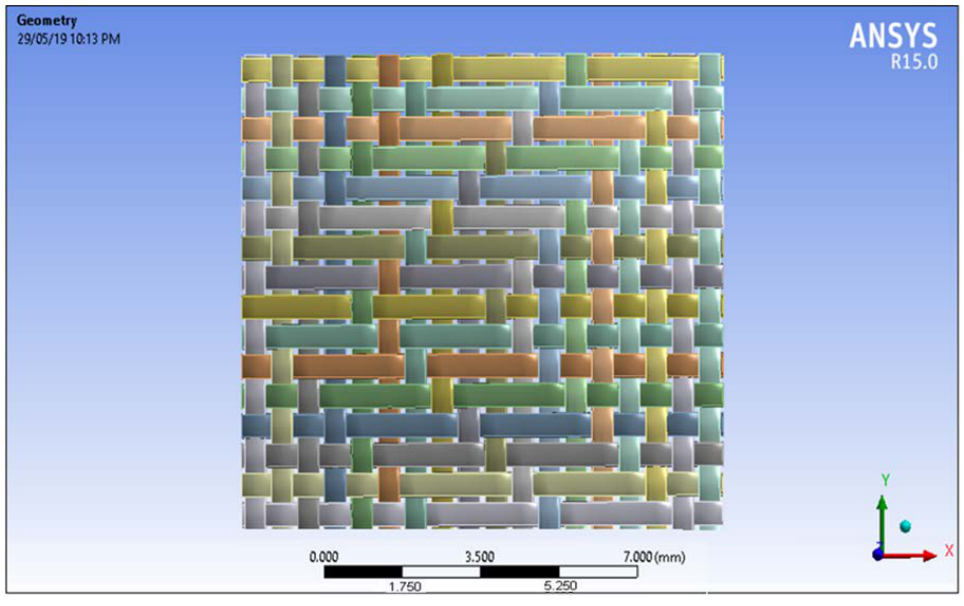
Figure 9. Contact definition in the model. Mesh generation: After the contact point generation, the mesh was generated as shown in Figure 10. The mesh size taken here was medium for easy processing and accuracy and element size was 0.125 mm by default.